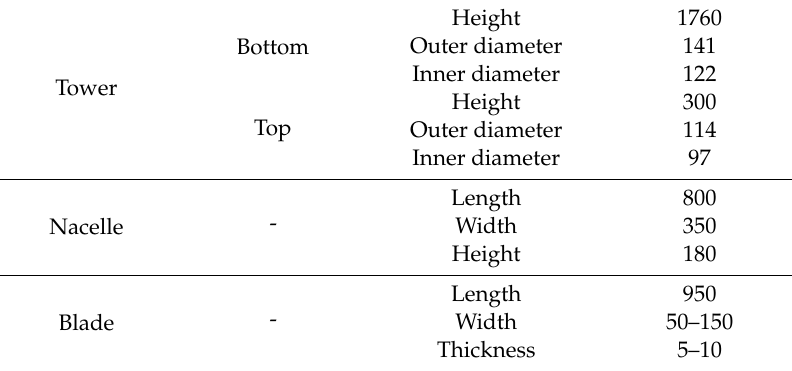
Figure 3. A wind turbine model, its finite element model, and test setup. ( a ) The wind turbine model; ( b ) the finite element model; ( c ) sensors arranged on the tower. Table 1. Size of the wind turbine model in the laboratory (mm).